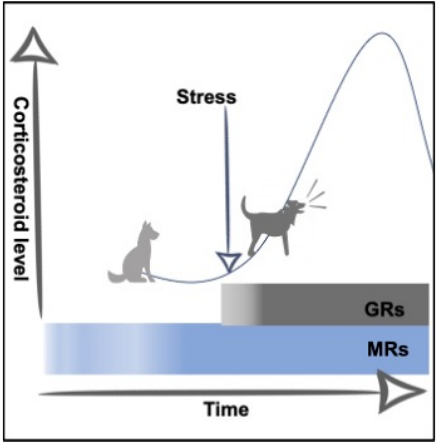
Figure 1. Schematic diagram showing mineralocorticoid and glucocorticoid receptors occupancy in baseline and stressful conditions. GRs = Glucocorticoid Receptors; MRs = Mineralocorticoid Receptors.